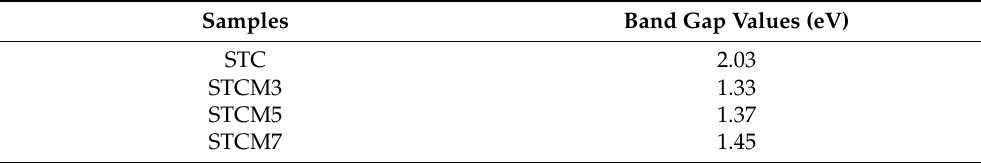
Table 2. The band energy of the STC and STCM materials.